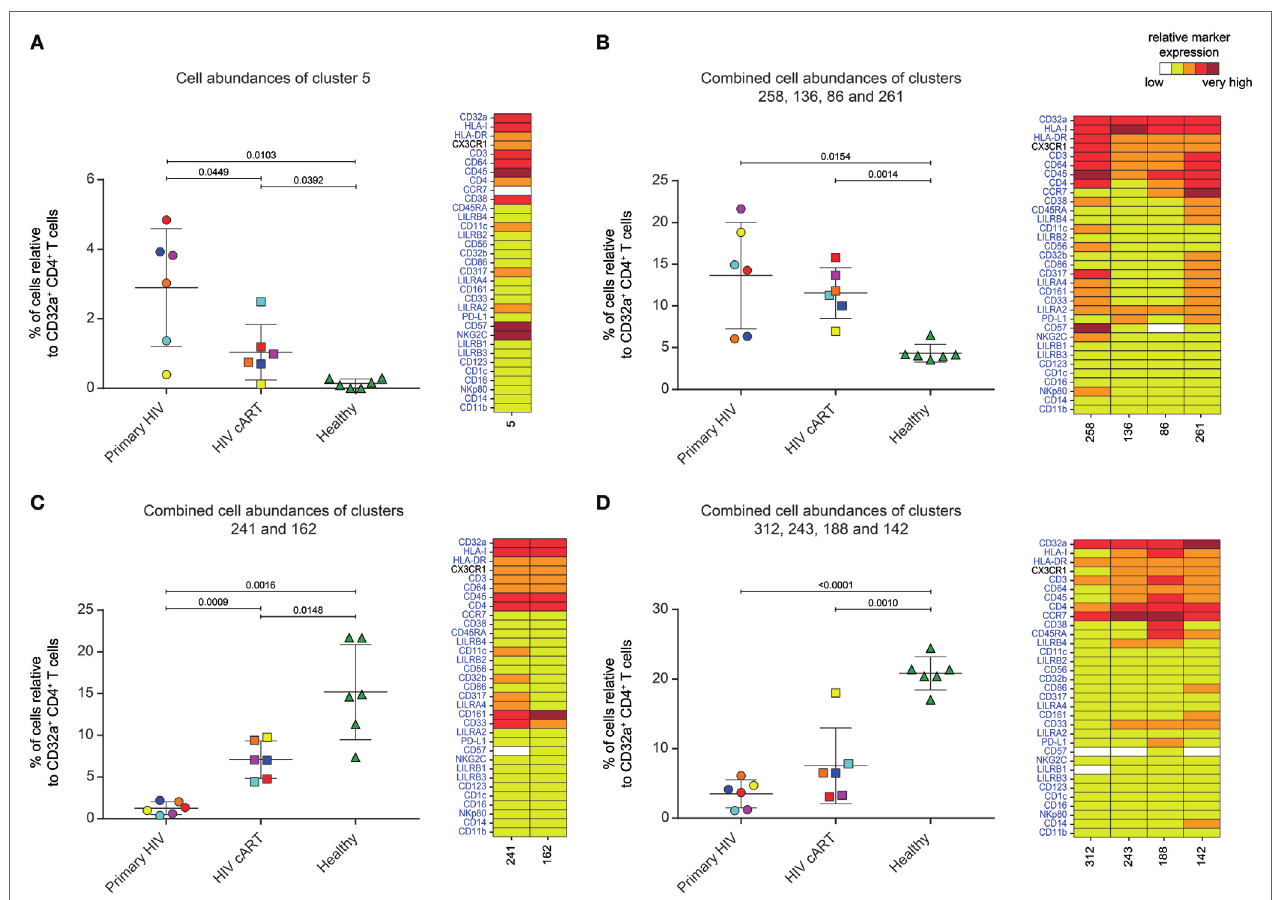
FigUre 3 | Characterization of CD32a + CD4 + T-cell clusters showing significant differences in cell abundance for HIV + conditions. (a) Graph showing the cell abundance of the cluster #5 relative to CD32a + CD4 + T cells for all samples, and heatmap representation illustrating the phenotype of this cluster. Cluster #5 was significantly more abundant under primary HIV (circle) and HIV cART (square) than healthy (triangle) conditions. This cluster was also more abundant under primary HIV than HIV cART conditions. (B) Graph showing the cell abundance of the clusters #258, #136, #86, and #261 relative to CD32a + CD4 + T cells for all samples, and heatmap representation of the phenotype of these clusters. These clusters were significantly more abundant under primary HIV and HIV cART than healthy conditions. (c) Graph showing the cell abundance of the clusters #241 and #162 relative to CD32a + CD4 + T cells for all samples, and heatmap representation showing the phenotype of these clusters. Clusters #241 and #162 were significantly less abundant under primary HIV and HIV cART than healthy conditions. These clusters were also less abundant under primary HIV than HIV cART conditions. (D) Graph showing the cell abundance of the clusters #312, #243 #188, and #142 relative to CD32a + CD4 + T cells for all samples, and heatmap representation showing the phenotype of these clusters. These clusters were significantly less abundant under primary HIV and HIV cART than healthy conditions. In the abundance graph representations, samples from the same HIV-infected patients were represented in the same color. For each condition, the mean cell abundance is indicated (black lines). Statistical differences between conditions were calculated using an unpaired Student’s t -test with a p -value threshold of 0.05. For heatmap representations, the relative marker expression for each cluster was indicated by a five-tiered color scale ranging from white (not expressed) to dark red (highly